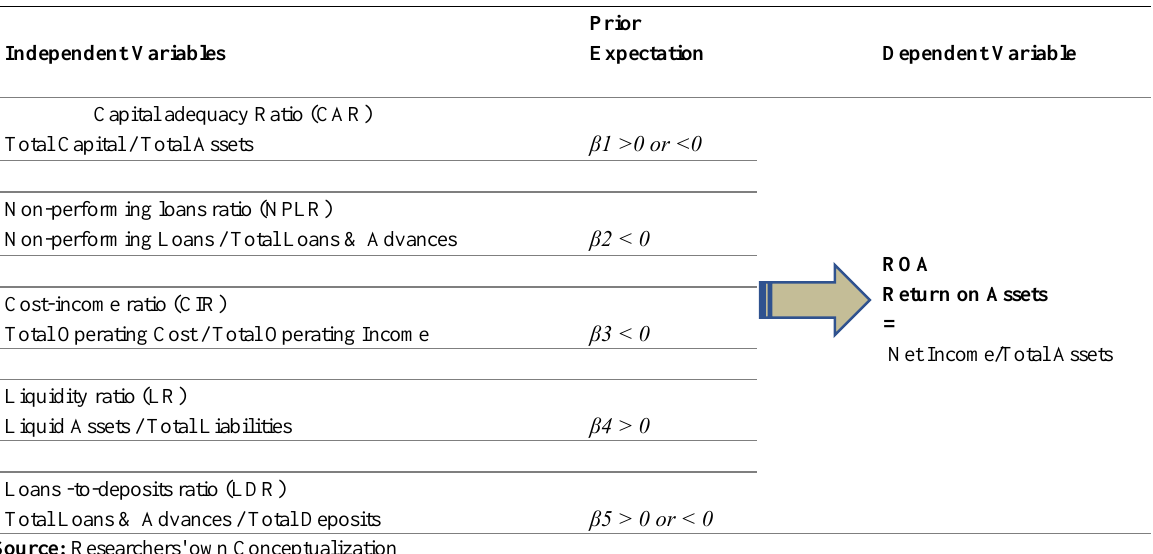
Table 1: Conceptual framework of the